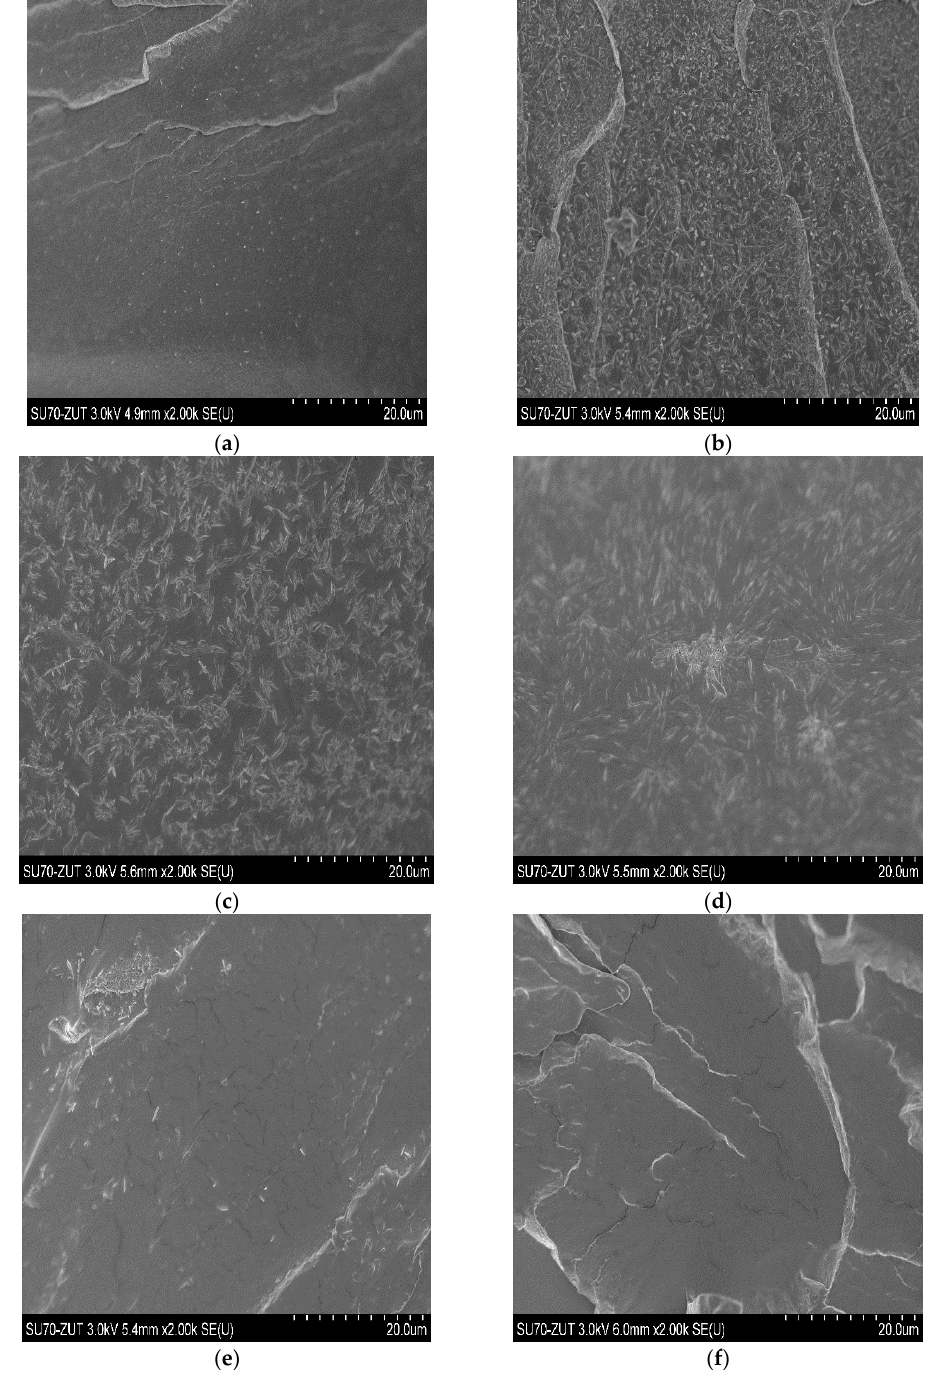
Figure 7. Scanning electron microscopy (SEM) micrographs of PHF, ( a ) and PHF- b -F-pTHF copolymers, 75/25 ( b ), 65/35 ( c ), 50/50 ( d ), 35/65 ( e ), and 25/75 ( f ).